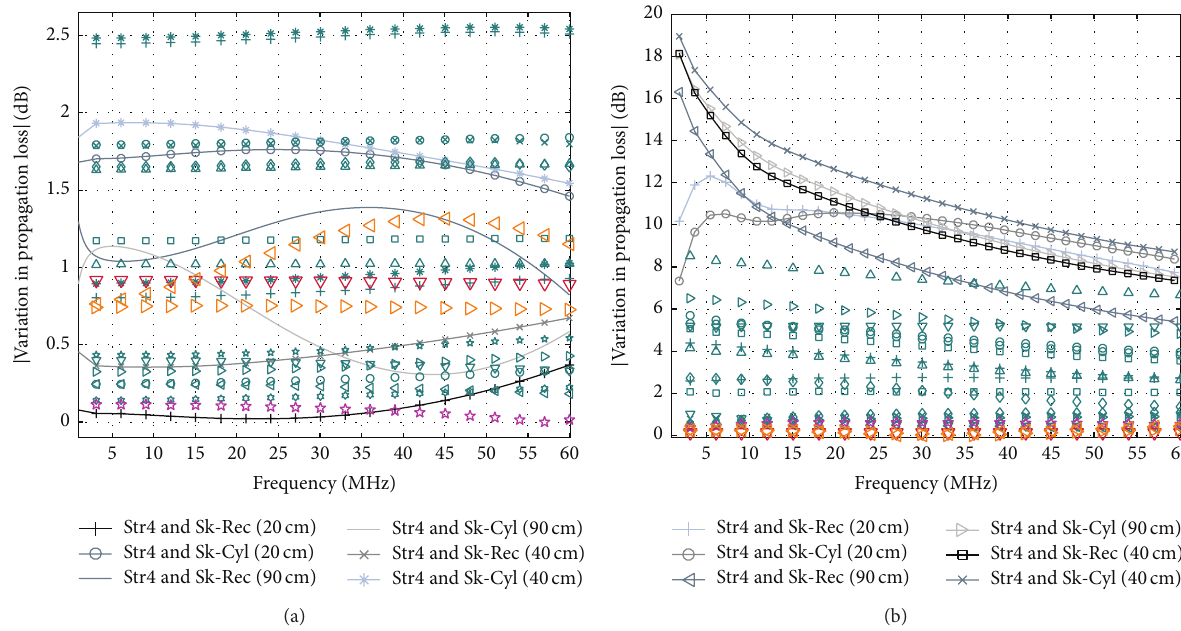
Figure 4: Variation in propagation loss among three human arm models: skin-only-cylinder (Sk-Cyl), skin-only-rectangle (Sk-Rec), and standard four-layer-stratified (Str4) for distances 20 cm, 40 cm, and 90cm with (a) vertical couplers [6 × 6 × 3], (b) horizontal couplers [5 × 2 × 1]; all coloured symbols show variations with boundary conditions, mesh sizes, dielectric properties, and dielectric layer thicknesses for Str4 human arm model with 40cm